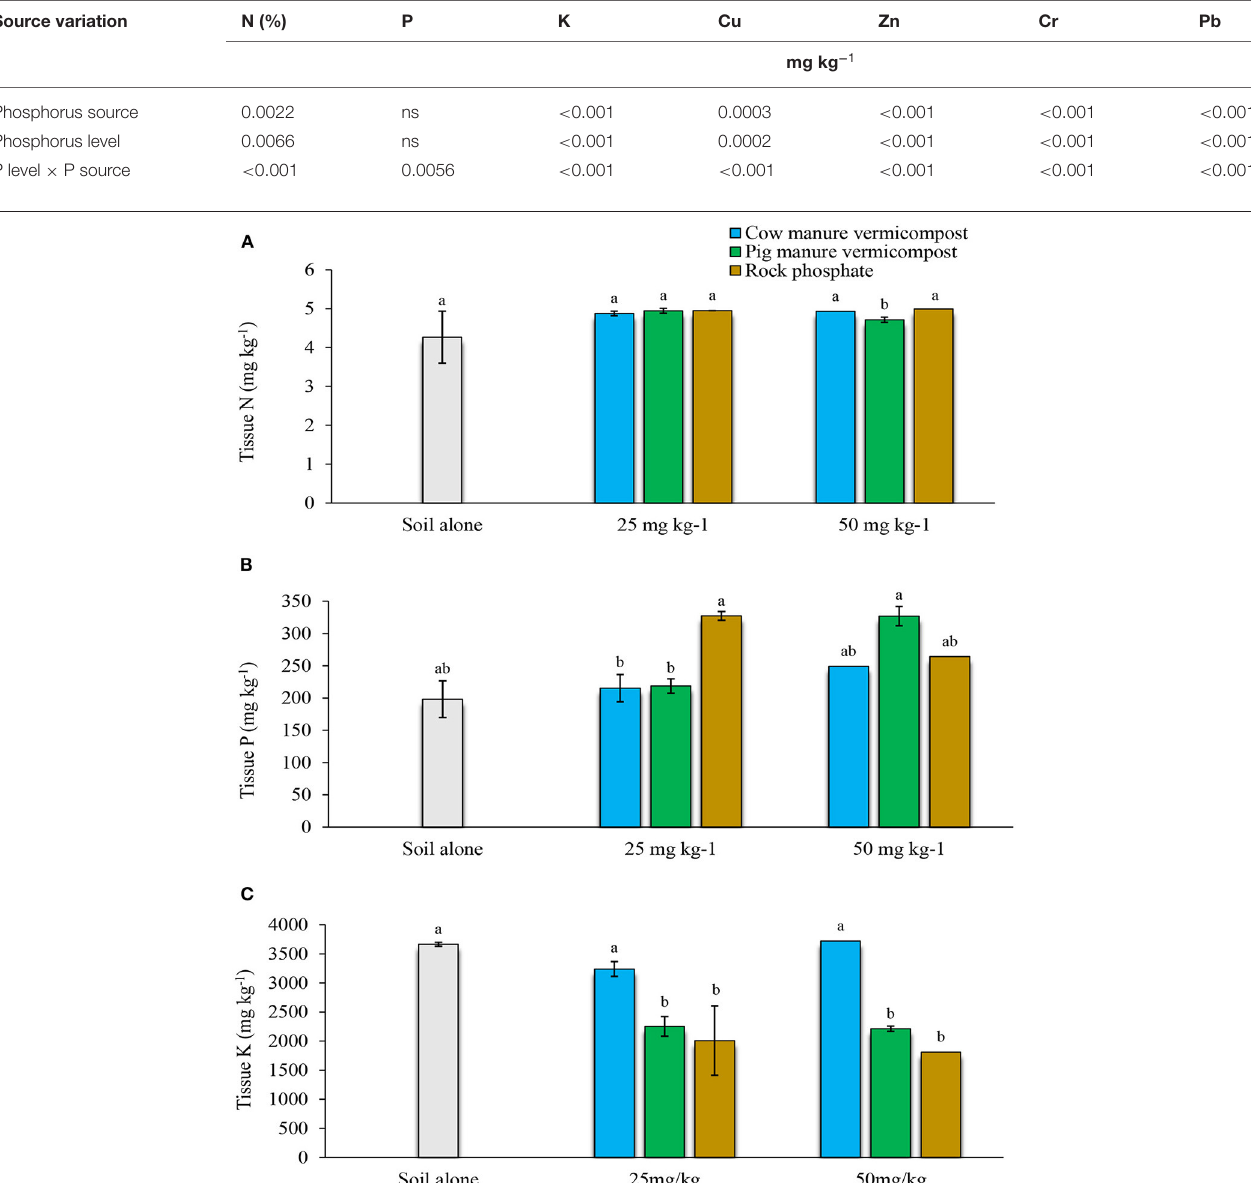
TABLE 3 | ANOVA for Swiss chard chemical properties in RP-enriched cow and pig manure vermicompost with Oxisol soil at week 8 after transplanting.